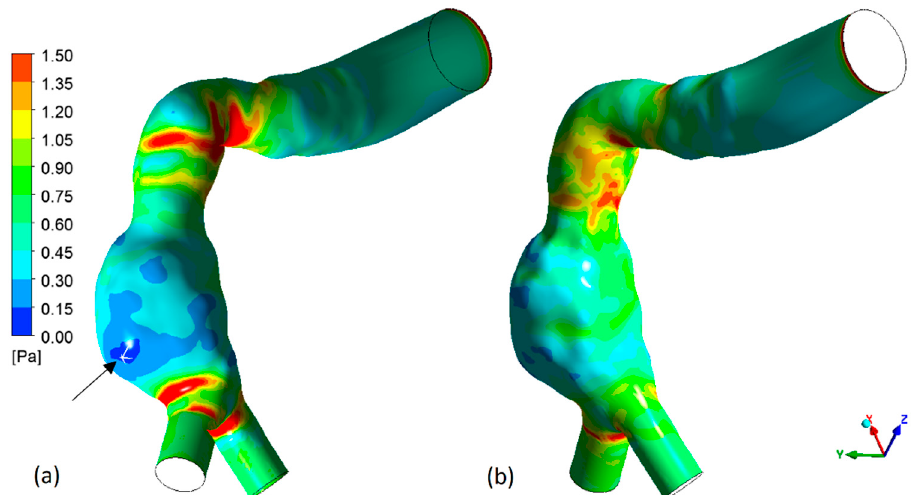
Figure 9. TAWSS contours distribution on the luminal surfaces of the rupturing aneurysm: ( a ) front view, ( b ) back view. The arrow and the white cross indicate the region where rupture really occurred (future rupture